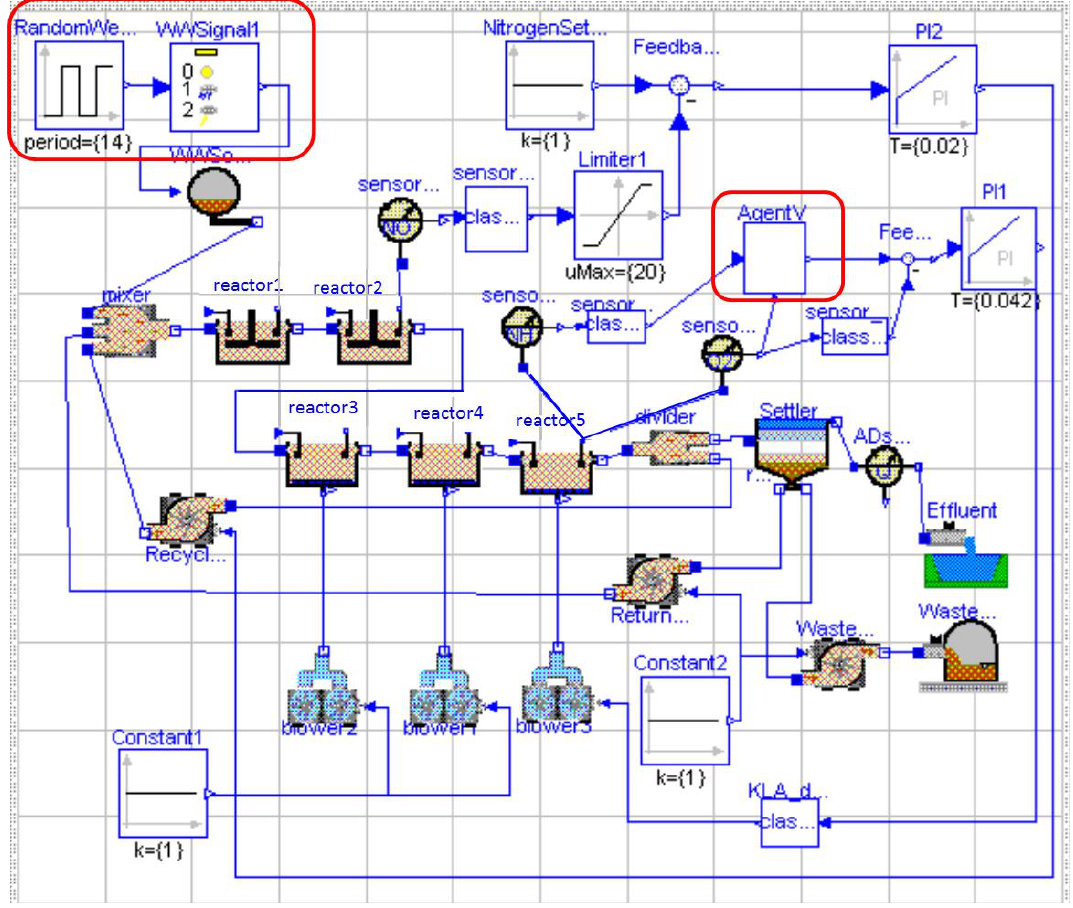
Figure 4. BSM1 with the model-free reinforcement learning (RL) agent controlling the dissolved oxygen (DO) set-point of Reactor 5.